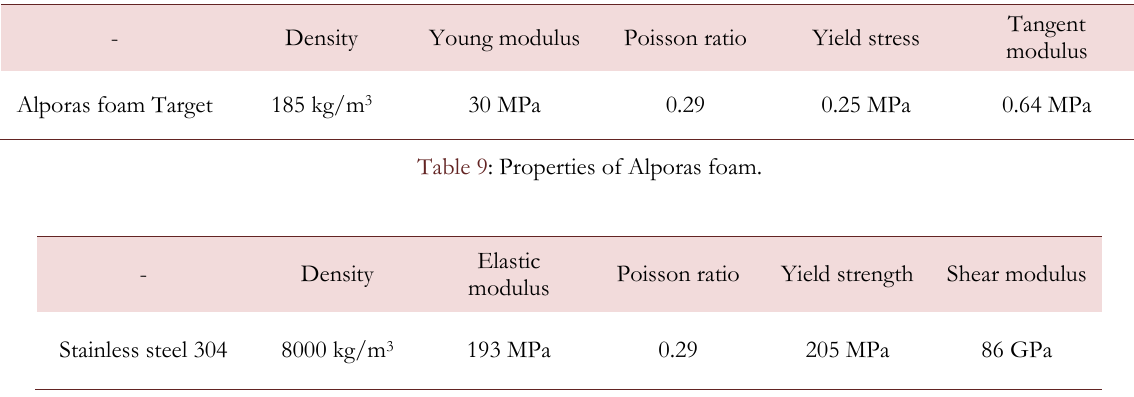
Table 10: Properties of stainless steel 304.